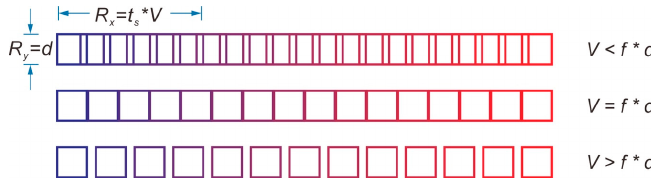
Figure 3. R x and R y are horizontal and vertical spatial resolutions respectively. Each square represents a laser pulse. To make the laser cover the entire surface of the mapped area, raster velocity ( V ) should not larger than the product of laser repetition rate ( f ) and spot size ( d ).